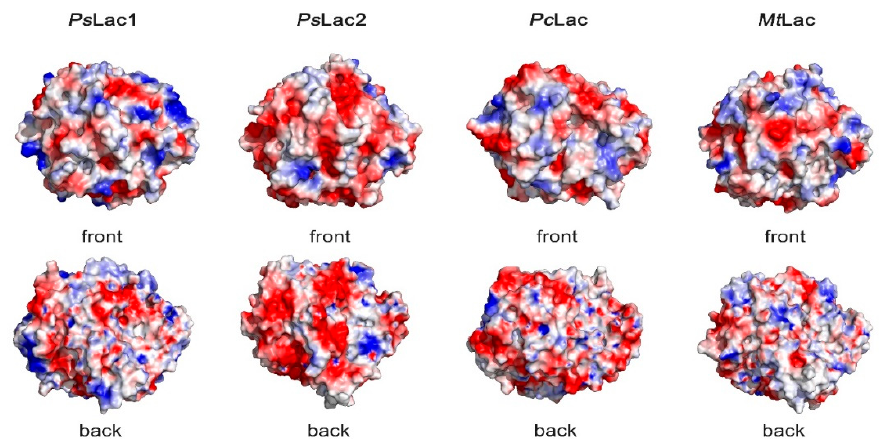
Figure 7. Surface charge plots (negative and positive charges are in red and blue, respectively) of Ps Lac1 and Ps Lac2 compared to those from Pycnoporus cinnabarinus laccase, Pc Lac (pdb: 2XYB) and from Myceliphthora thermophila laccase, Mt Lac (pdb: 6F5K). The surface potentials were calculated using the vacuum electrostatics function of the PyMOL molecular graphics system (Schrödinger, New York, NY,